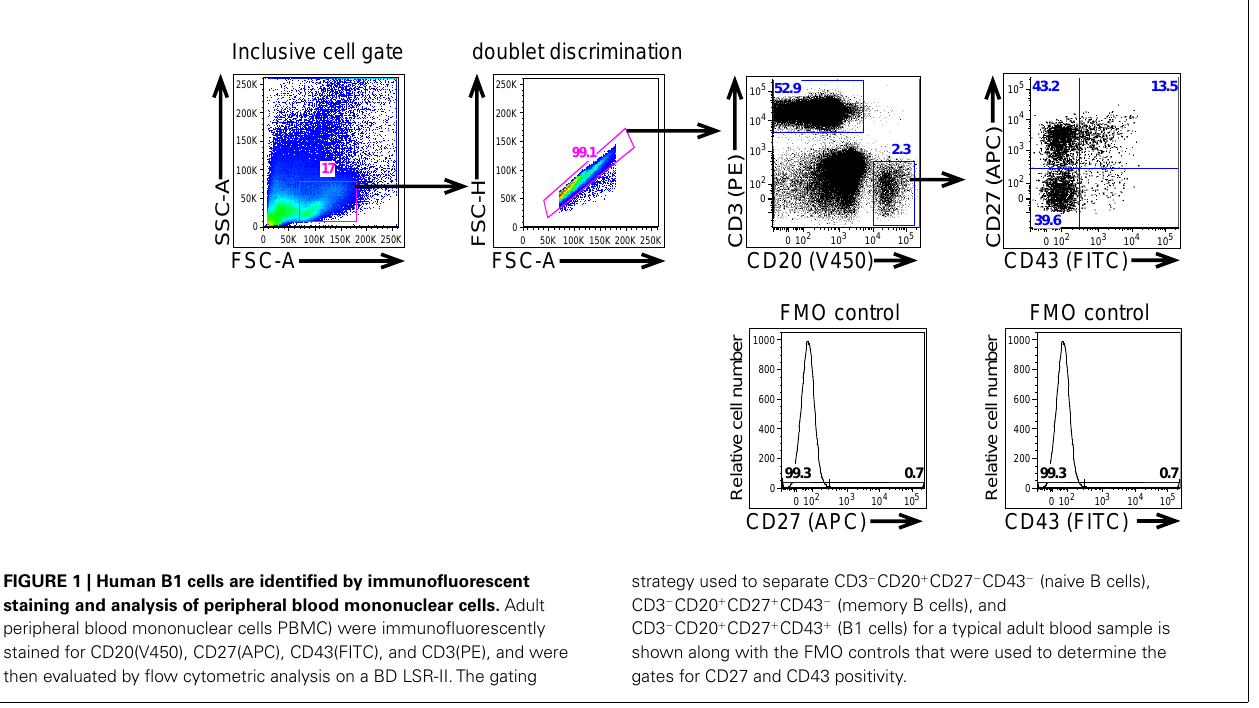
FIGURE 1 | Human B1 cells are identified by immunofluorescent staining and analysis of peripheral blood mononuclear cells. Adult peripheral blood mononuclear cells PBMC) were immunofluorescently stained for CD20(V450), CD27(APC), CD43(FITC), and CD3(PE), and were then evaluated by flow cytometric analysis on a BD LSR-II.The gating